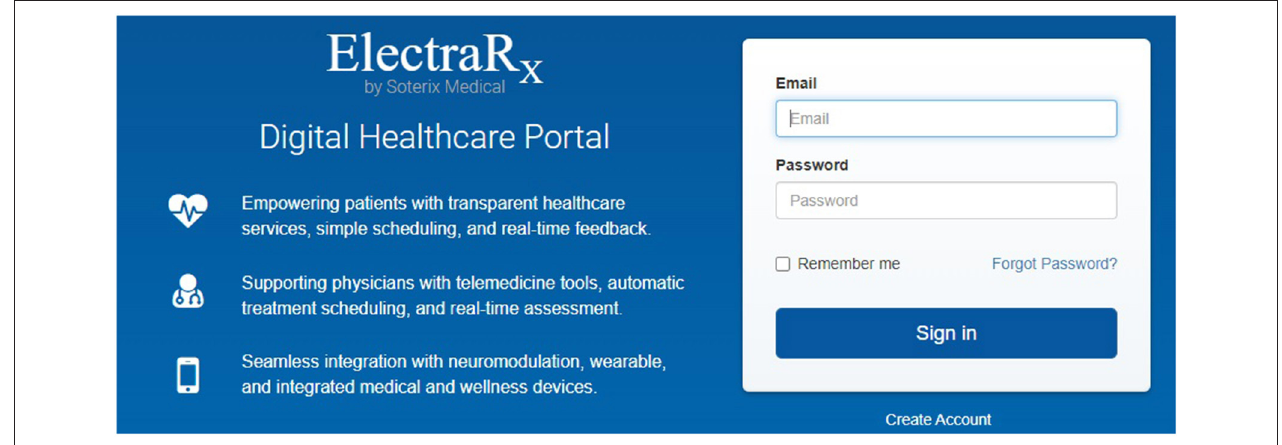
FIGURE 1 | Remote tDCS website set-up. Further details can be found at: https://soterixmedical.com/research/remote/electrarx.